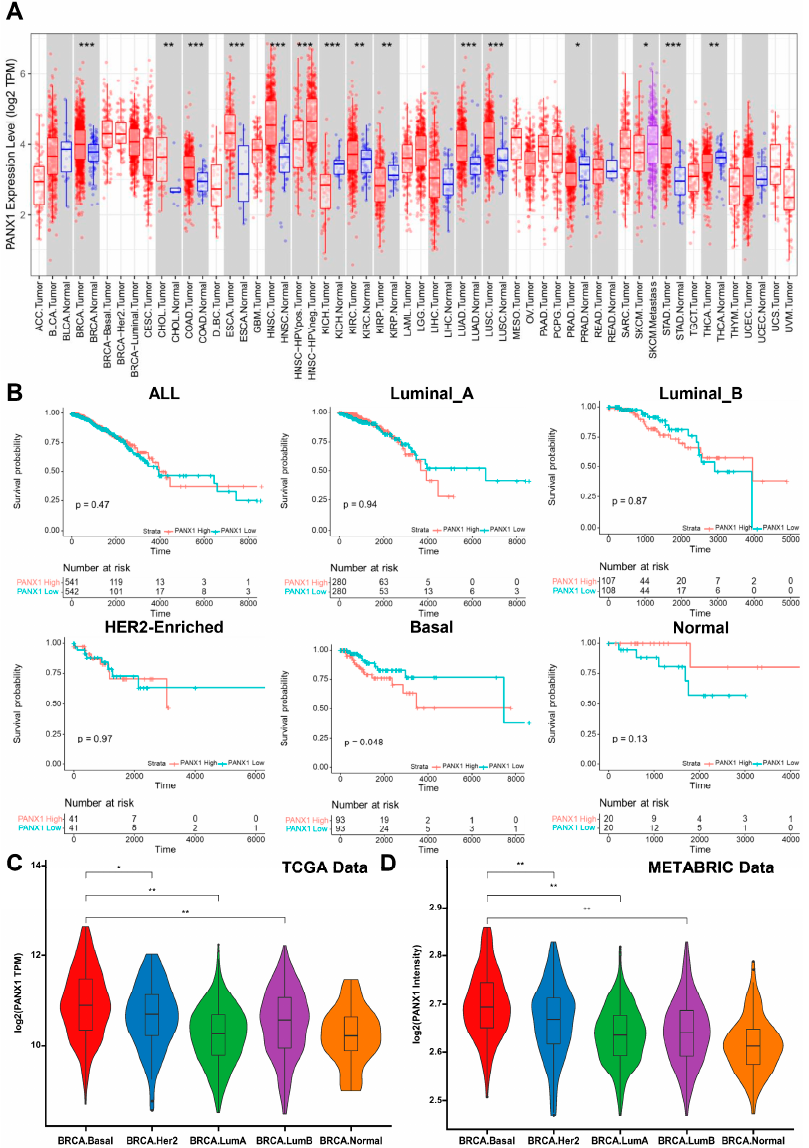
Figure 1. ( A ) PANX1 was highly expressed in breast cancer (BRCA), colon adenocarcinoma (COAD), esophageal carcinoma (ESCA), head and neck squamous cell carcinoma (HNSC), kidney chromophobe (KICH), lung adenocarcinoma (LUAD), lung squamous cell carcinoma (LUSC), and stomach adenocarcinoma (STAD) compared with normal tissues ( p < 0.001 as significant; Student’s t test) (TCGA-BRCA data; red bar: tumor tissue; blue bar: normal tissue); ( B ) correlation between PANX1 expression and overall survival (OS) in breast cancer under PAM50 molecular intrinsic subtypes (All (n = 1083), Luminal A (n = 560), Luminal B (n = 215), HER2-enriched (n = 82), Basal (n = 186), and Normal (n = 40)); ( C , D ) PANX1 expression under different PAM50 breast cancer molecular intrinsic subtype (TCGA-BRCA (n = 1083) and METABRIC (n = 1699) data, PAM50 algorithm; Turkey’s